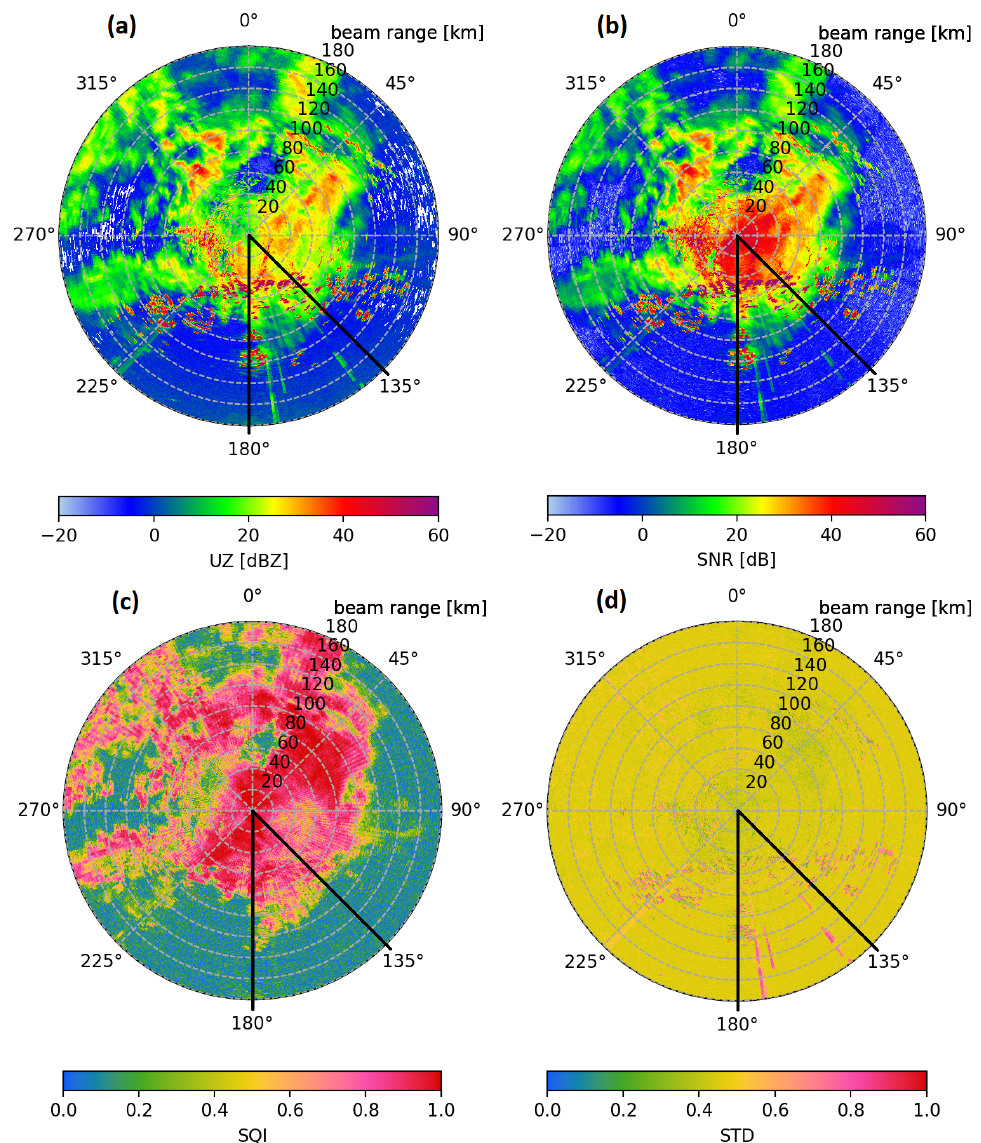
Figure 1. Example PPIs from radar site at Isen of the 0.5 ◦ volume sweep on 15 March 2022 at 15:32UTC. Shown are uncorrected reflectivity (UZ), signal-to-noise ratio (SNR), signal quality index (SQI) and pulse-based normalised standard deviation (STD). Within the azimuth section from 135 to 180 ◦ (marked by the black lines) multiple linear signatures caused by external interference can be seen in panels (a) , (b) and (d) . The effect of another weaker inference can be seen near 225 ◦ . Table 1. Three classifications that are used to describe an RFI are listed here. The classification is done by evaluating the most disturbed azimuth angle from the RFI box and determining if the fraction of these specific disturbed rays exceeds the specified threshold. An RFI may fall under multiple RFI classes. The sum of reference values uniquely identifies the combination of applicable RFI